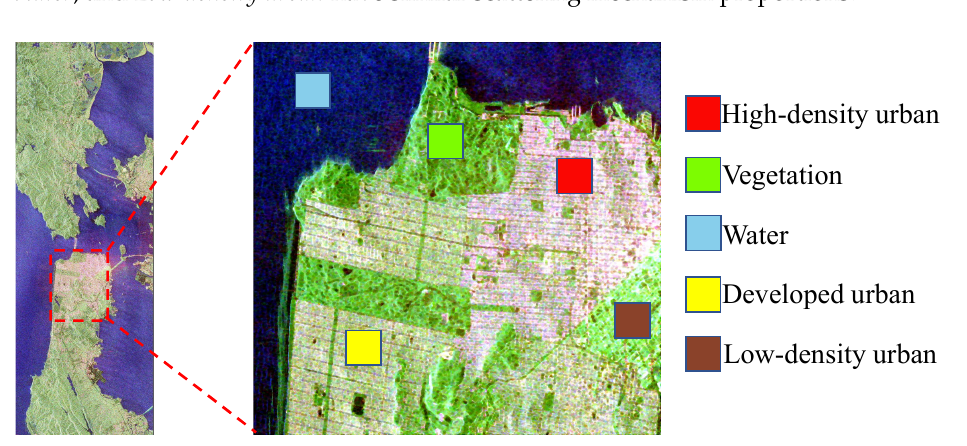
Figure 26. PauliRGB image of RS2 San Francisco dataset (Red: double-bounce scattering power. Green: volume scattering power. Blue: surface scattering power).